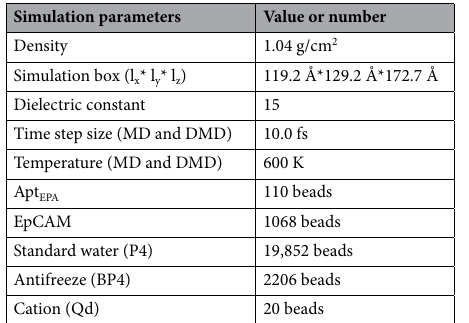
Table 1. The STUN-BH-DMD simulation parameters for the MARTINI CG